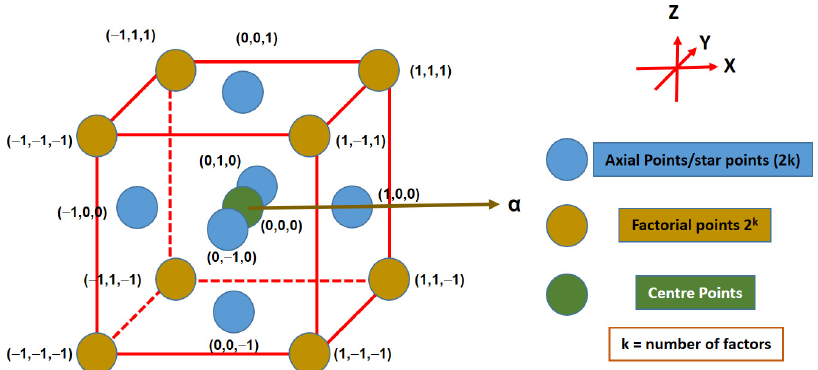
Figure 3. Central composite design (CCD) for three factors used in the present work.